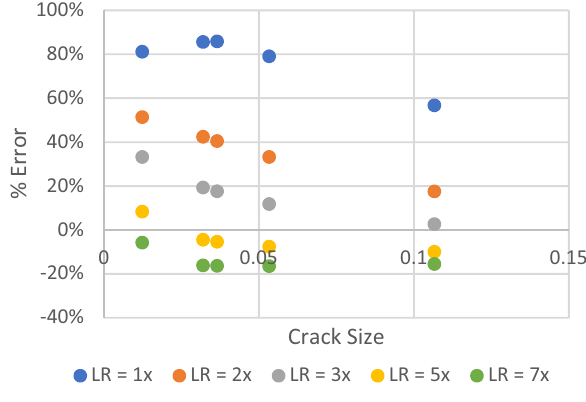
Fig. 16 Error in stress intensity factors for plate with 60-degree v-notch